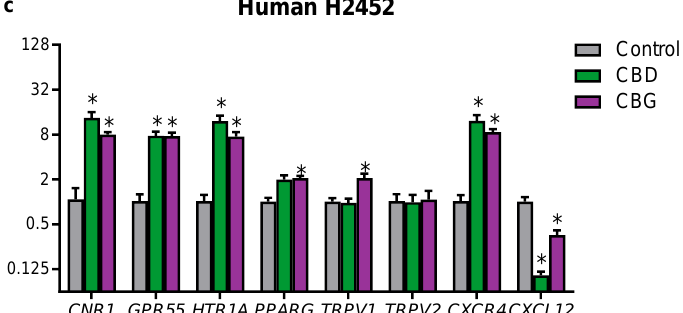
Figure 5. The phytocannabinoids cannabidiol (CBD) and cannabigerol (CBG) affected mRNA ex- pression of cannabinoid and mesothelioma-related targets in cultured mesothelioma cells. Gene expression was quantified by RT-qPCR in ( a ) rat II-45 and human ( b ) MSTO and ( c ) H2452 mesothe- lioma cells. FC in gene expression was calculated relative to untreated control cells using the 2 -delta-delta Ct method after normalizing to TBP. Bars show the means and SD in gene expression relative to control ( n = 3). Grey bars represent a fold change (FC) of one in control treated cells. p -values were calculated using two-way ANOVA Holm–Sidak’s multiple comparisons. * p < 0.01 relative to vehicle treated control cells and FC < 0.5 or